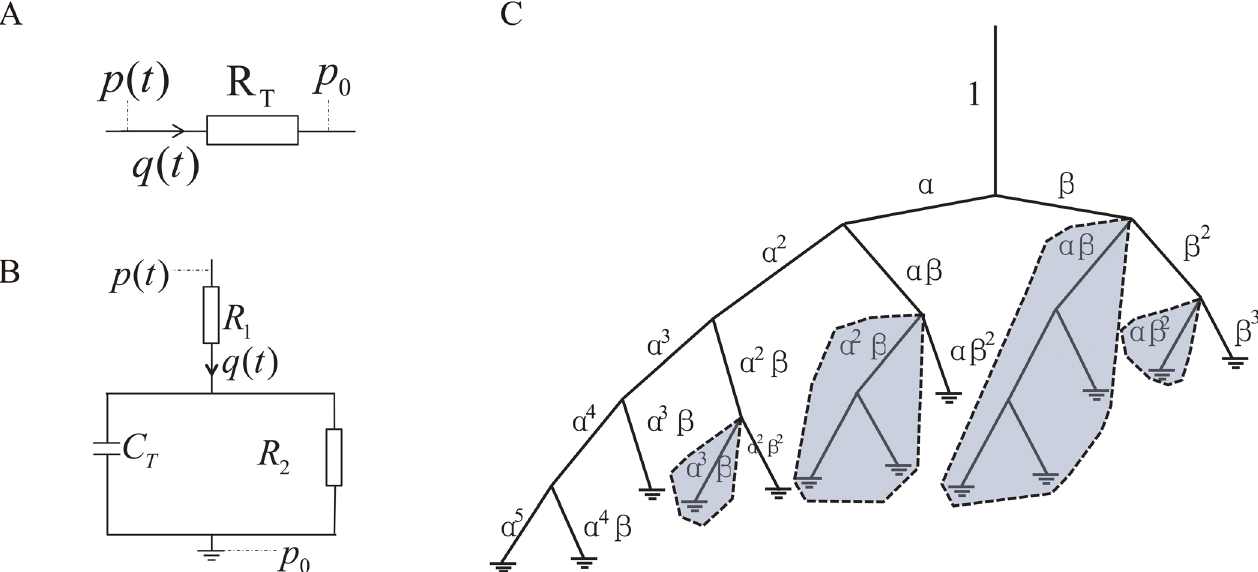
Fig 2. Illustrations of the outflow boundary conditions. A: the CR model. B: the three-element WK and CWK models. C: the ST model, where α and β are the the bifurcation ratios (see text).